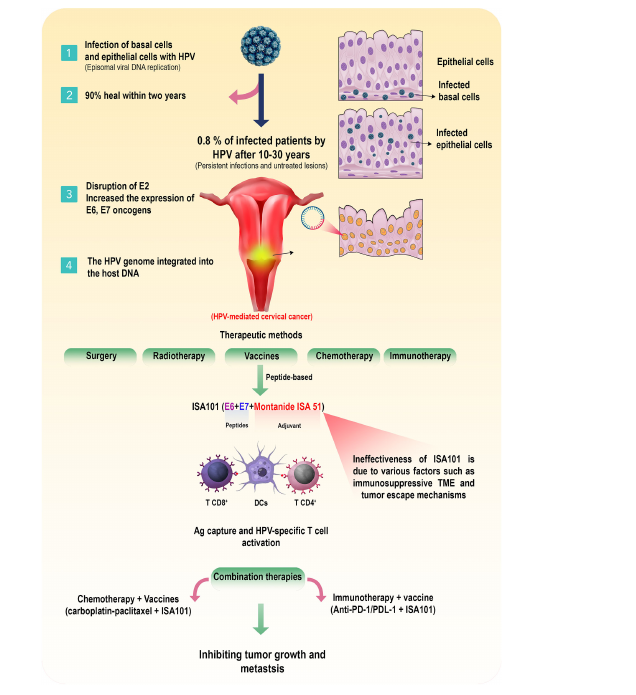
TABLE 2 The whole sequence of HPV-16-derived E6 and E7 oncoproteins in